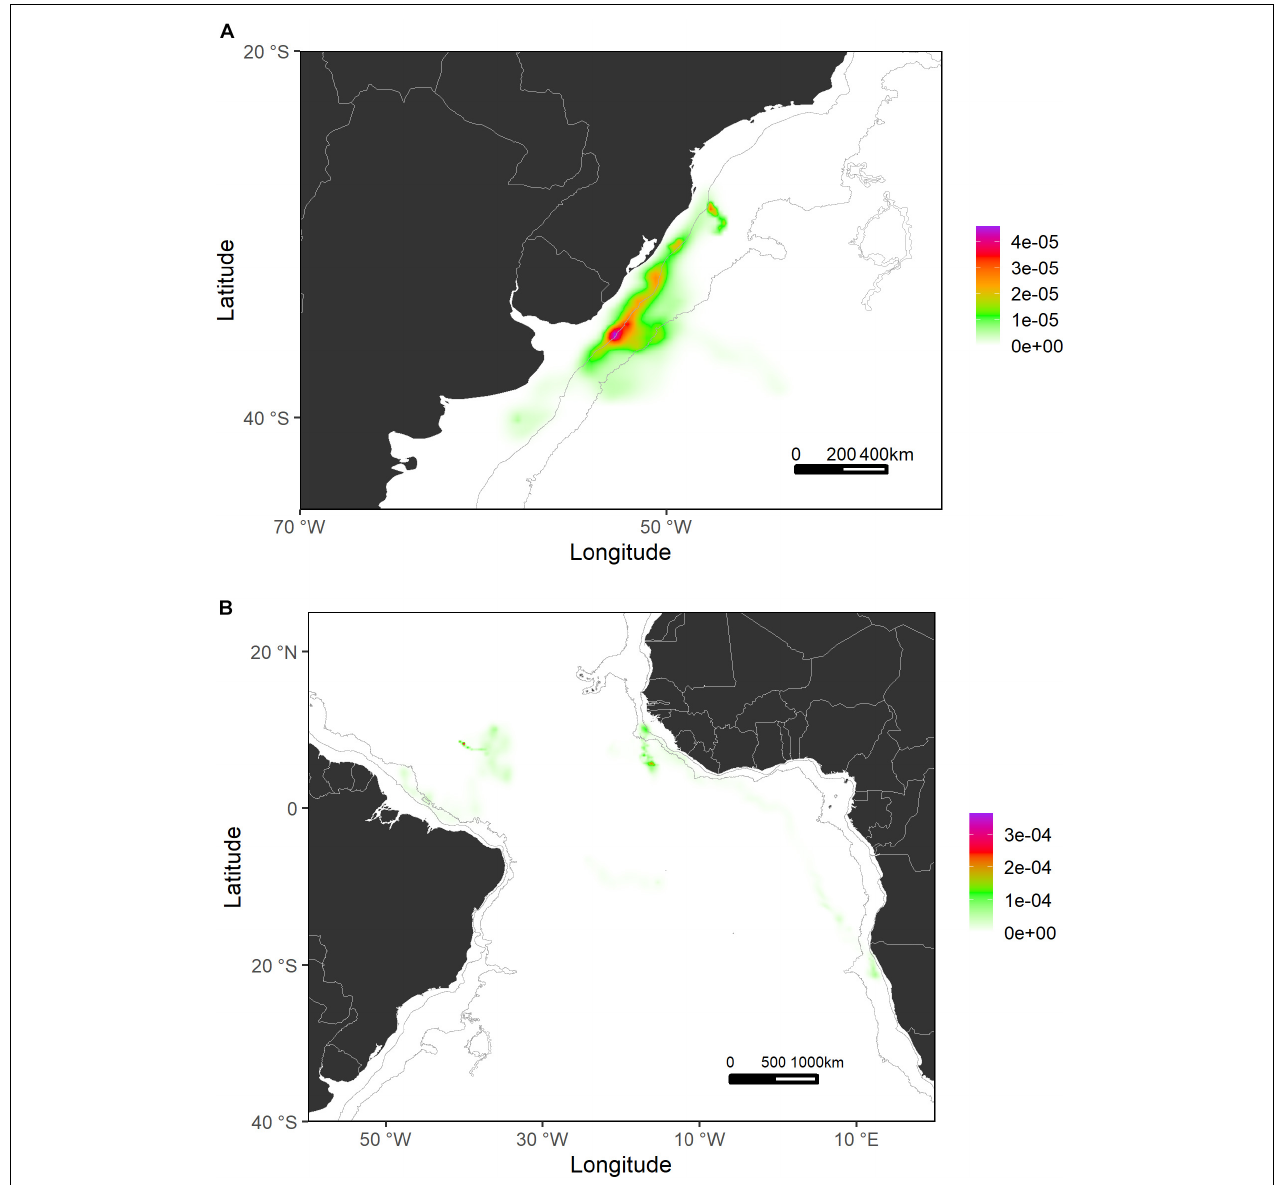
FIGURE 5 | Probability surfaces of the spatial distribution of shortfin makos tagged in the Southwest Atlantic (A) and Central Atlantic (B) regions. Gray lines represent the boundaries of continental and insular margins (140–3,500 m